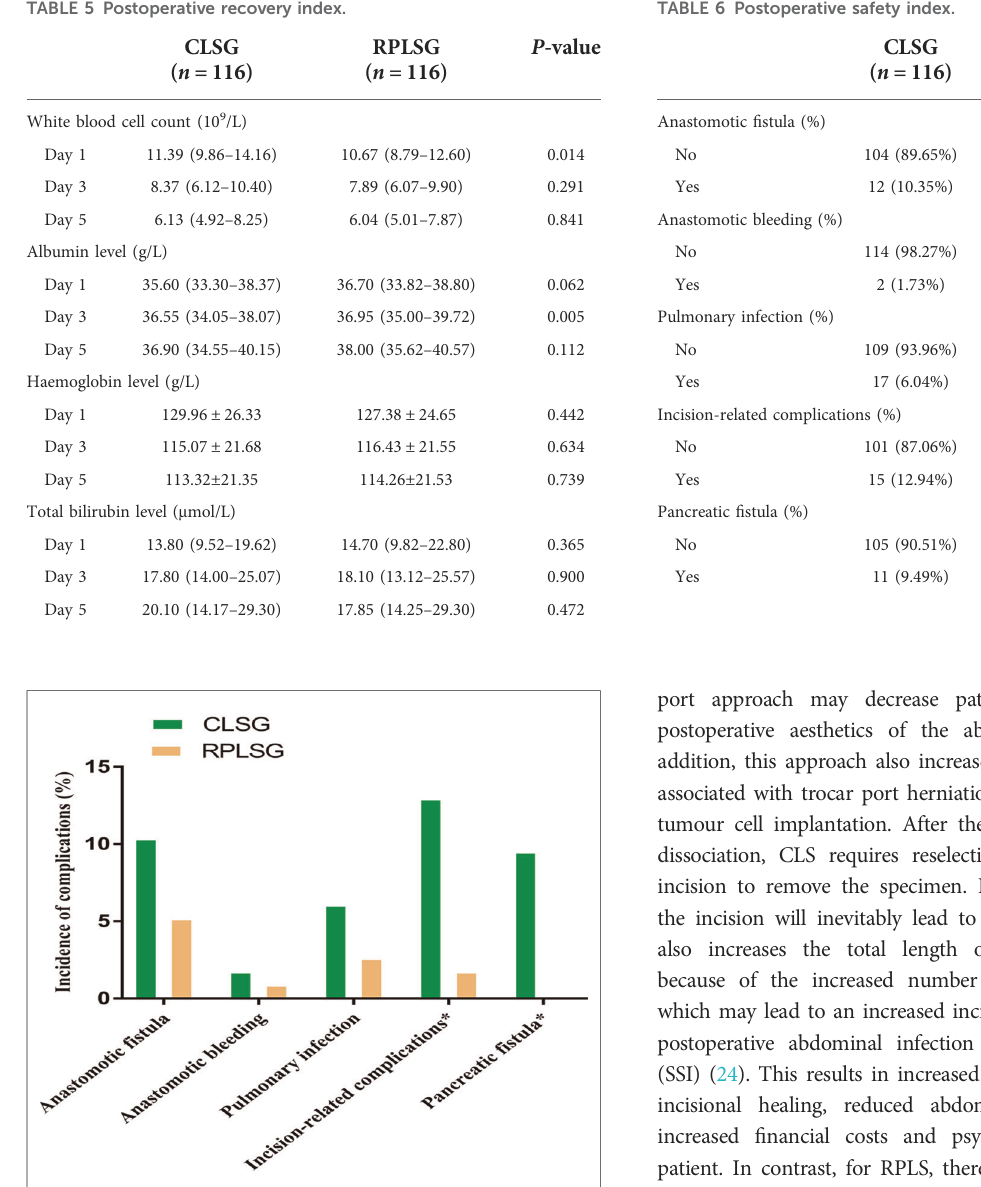
TABLE 5 Postoperative recovery index.